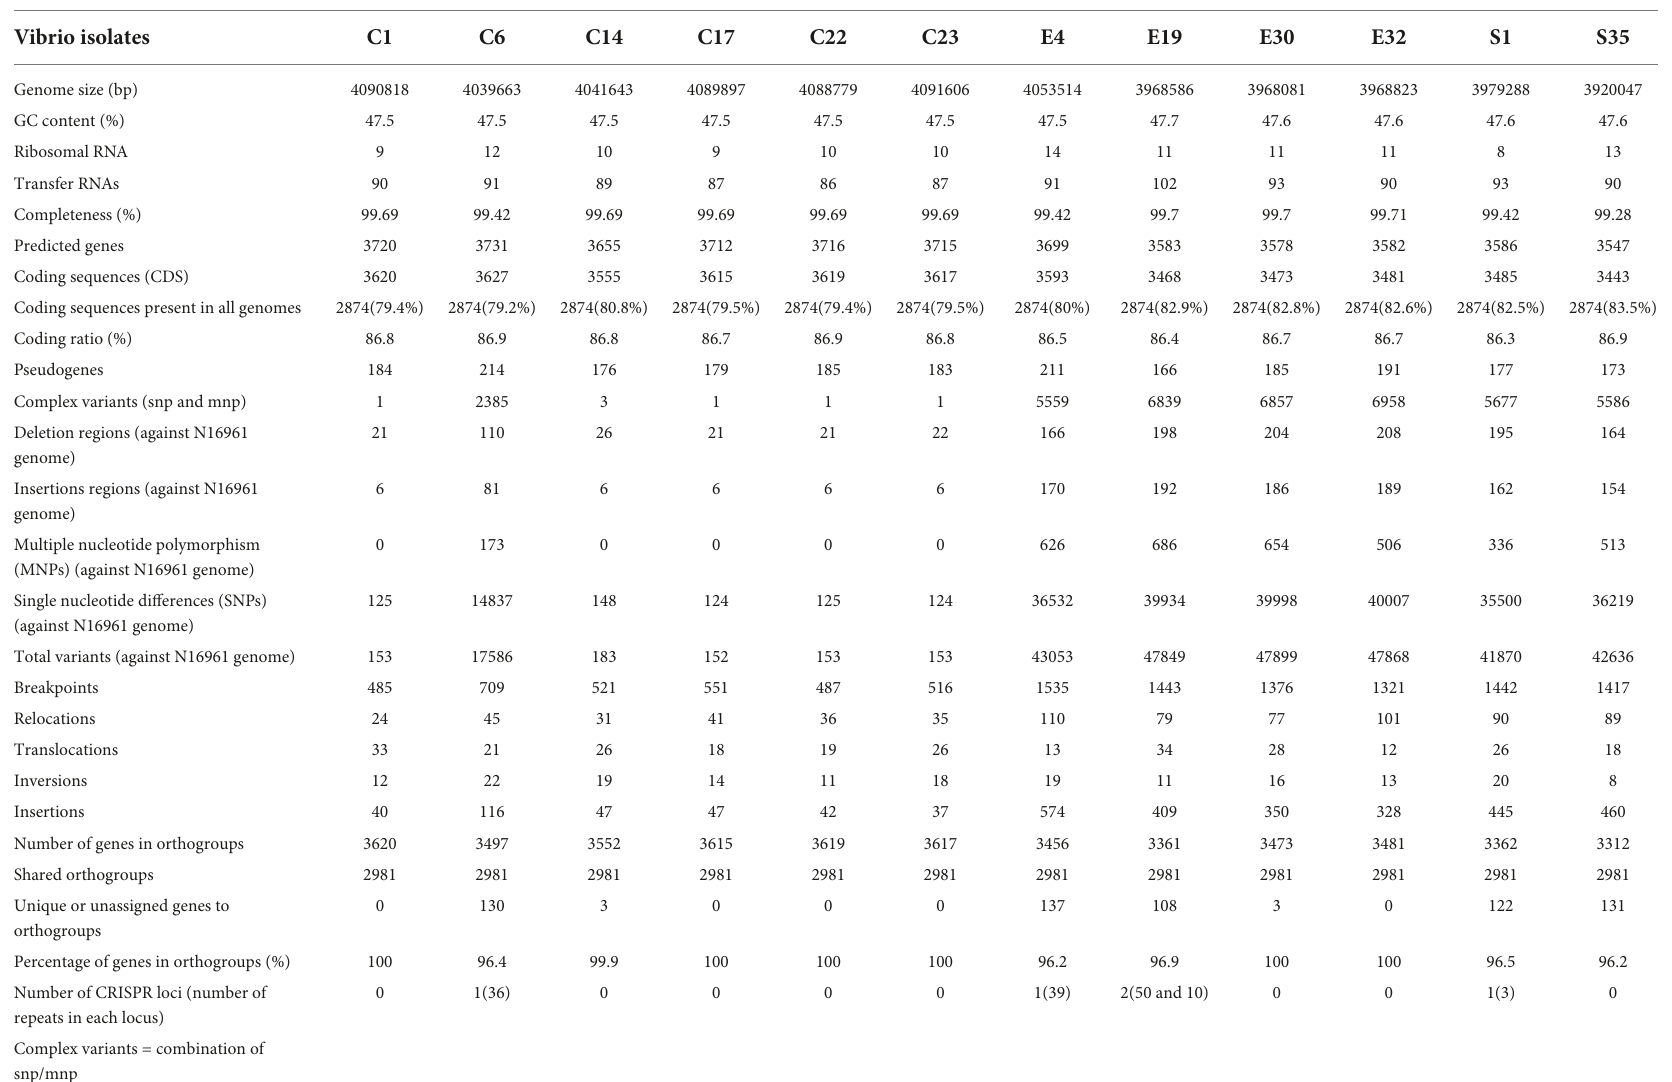
TABLE 2 General features of the Vibrio cholerae